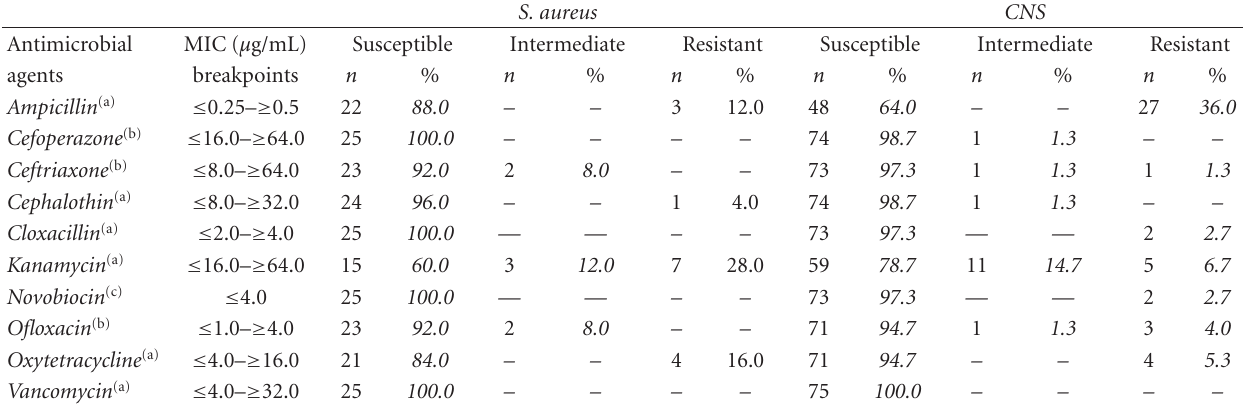
Table 2: Antimicrobial susceptibility of S. aureus and CNS strains isolated from goats subclinical mastitis. S. aureus